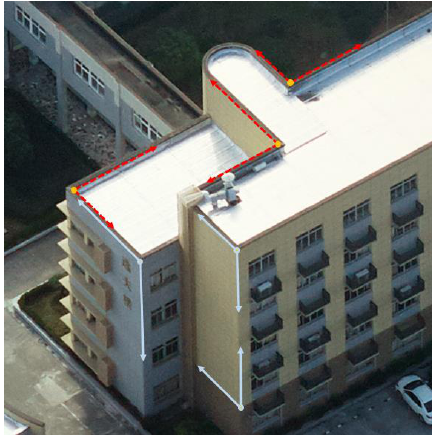
Figure 2. The L-junctions in white solid lines can be used to extract planes, while those in red dash lines cannot.